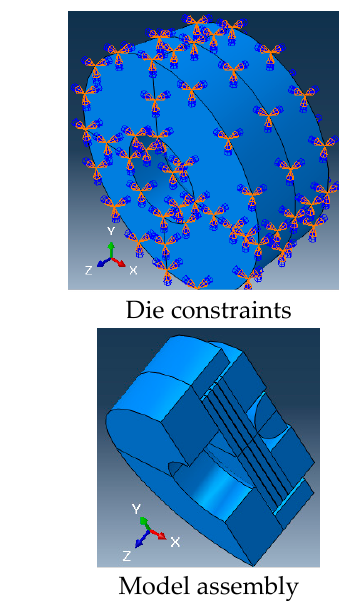
Figure 4. Constrains and assembly of the different elements of the FE model. The current modeling analysis simulated the die (two parts) and the punch with linear brick elements (eight nodes, C3D8R elements). The composite specimen layers were represented by 8 ‐ node quadrilateral continuum shell elements (SC8R), which is compatible with Hashin’s damage model. An 8 ‐ node three ‐ dimensional cohesive ele ‐ ment (COH3D8) was used to model the cohesive layers. Figure 5 shows the mesh of the different elements of the finite element model. The mesh element size of the composite layers was taken as 0.7 mm [31]. Figure 6 shows the effect of the cohesive elements’ size in the model results. The figure shows that the most suitable element size for the cohe ‐ sive layer was five times its thickness, t .